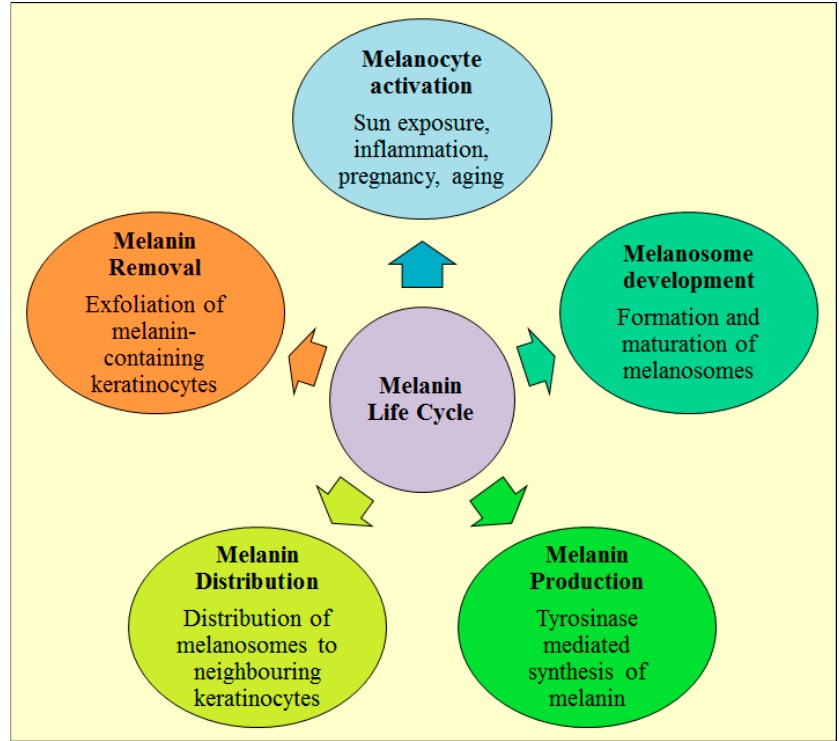
Figure 1. Various stages of melanin life cycle (i) melanocyte activation, (ii) melanosome development, (iii) melanin production, (iv) melanin distribution and (v) melanin removal.